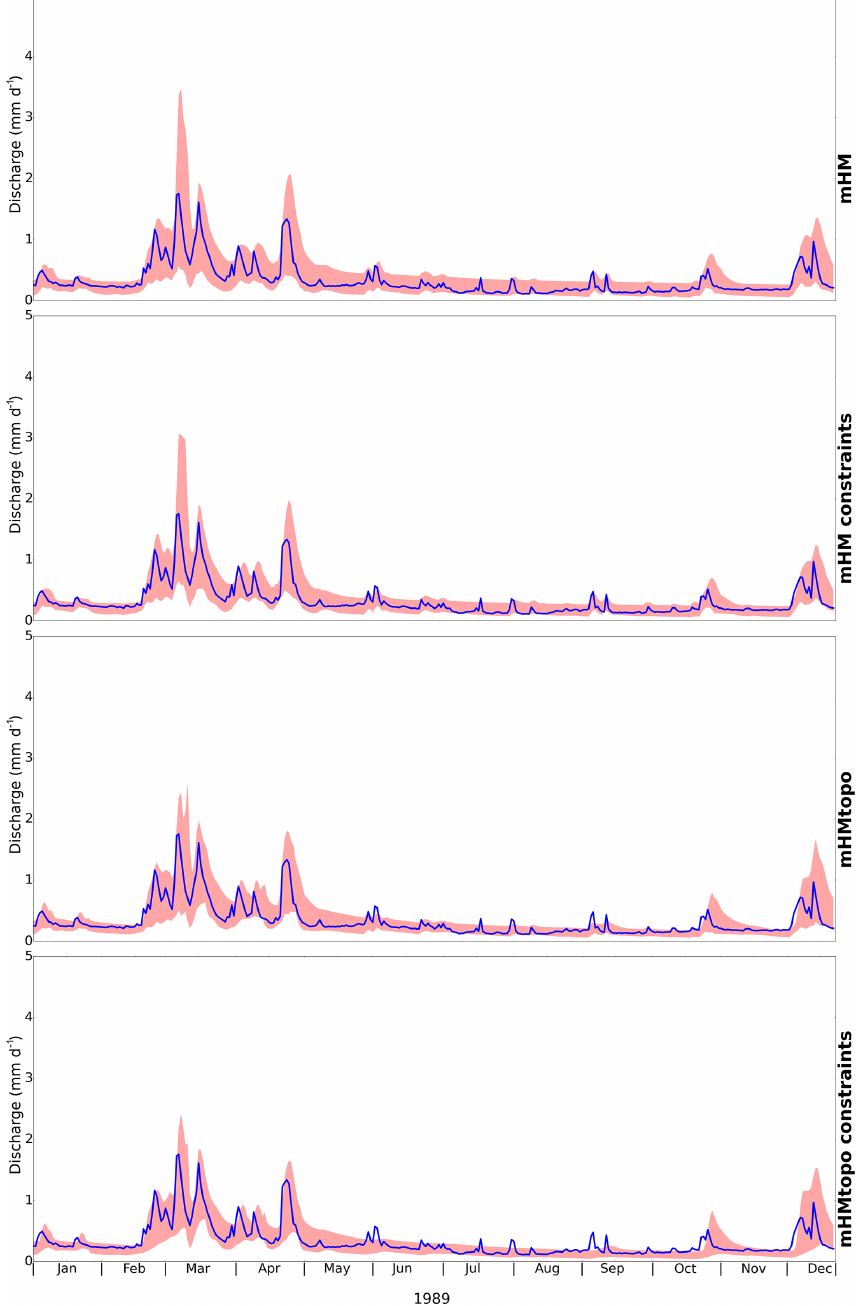
Figure 8. Hydrographs for the Orge catchment, with, respectively, the hydrographs for mHM, mHM with constraints, mHMtopo and mHM- topo with constraints. The red shaded areas represent the envelope spanned by all feasible solutions, whereas the blue line corresponds to observed